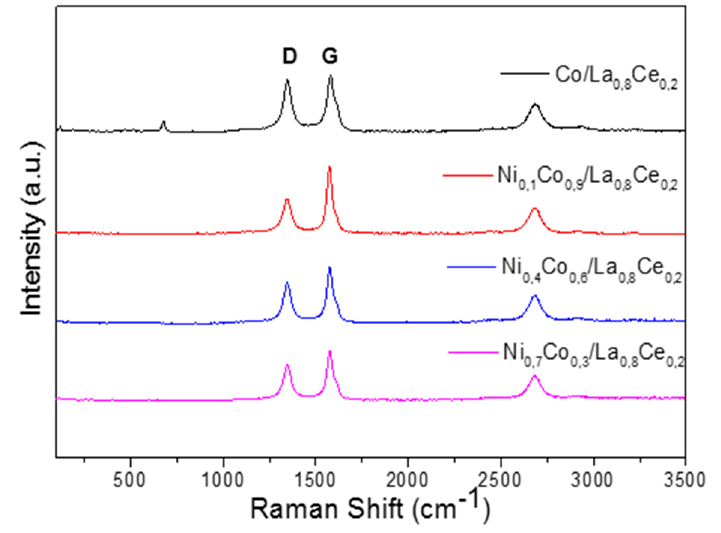
Figure 15. Raman spectra supported Ni x Co 1-x /La 0.8 Ce 0.2 catalysts.